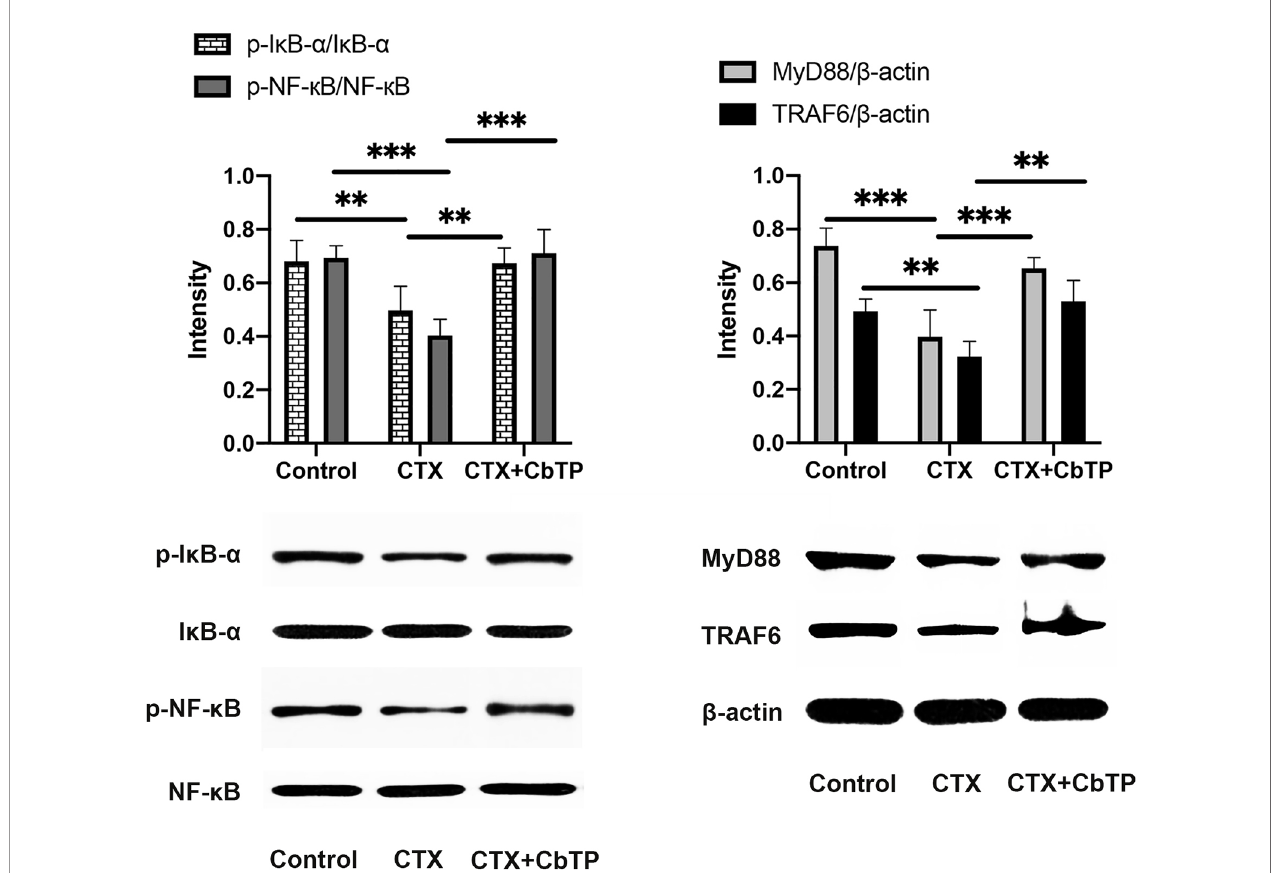
FIGURE 11 | CbTP promotes the MyD88-NF- k B signaling pathway in the serum of mice. Total and phosphorylated protein levels of MyD88, TRAF6, I k B- a , NF- k B and b -actin in the serum, as depicted by western blotting. Statistical comparisons were performed by Student ’ s t test. Data are given as the mean ± standard deviation (n = 5). **p ≤ 0.01; ***p ≤